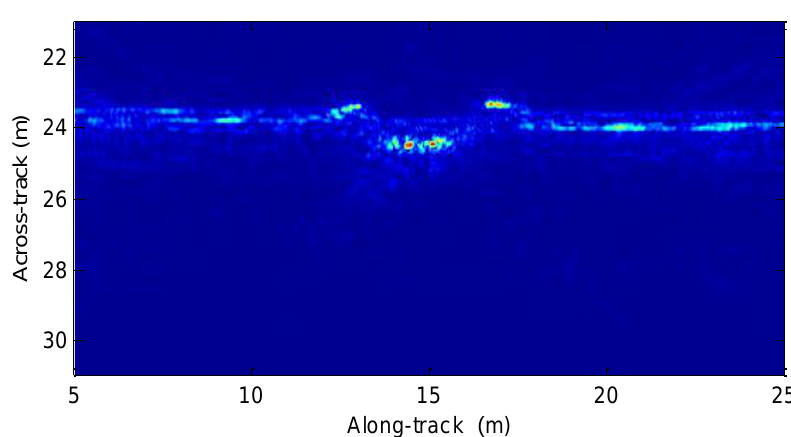
Figure 23. Motion error with real data. Sensors 2018 , 18 , x FOR PEER REVIEW